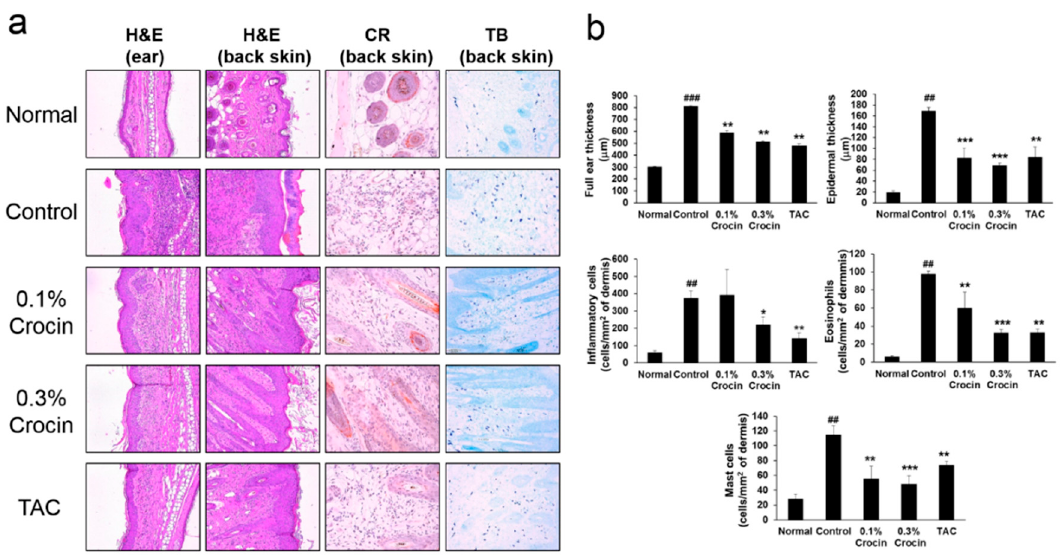
Figure 3. Histopathology and histomorphometrical analysis of the ear and back skin tissues. ( a ) Ear and back skin sections were stained with hematoxylin and eosin (H&E; original magnification × 200). Back skin sections were stained with Congo red (CR; × 400) or toluidine blue (TB; × 200). ( b ) Full ear thickness in the ear, epidermal thickness, inflammatory cells number, eosinophils number, and mast cells number in the back skin. Results are expressed as mean ± standard error of the mean (S.E.M.) for six mice. Groups: Normal, no treatment group; Control, DfE-treated group; Crocin, 0.1%- or 0.3%-